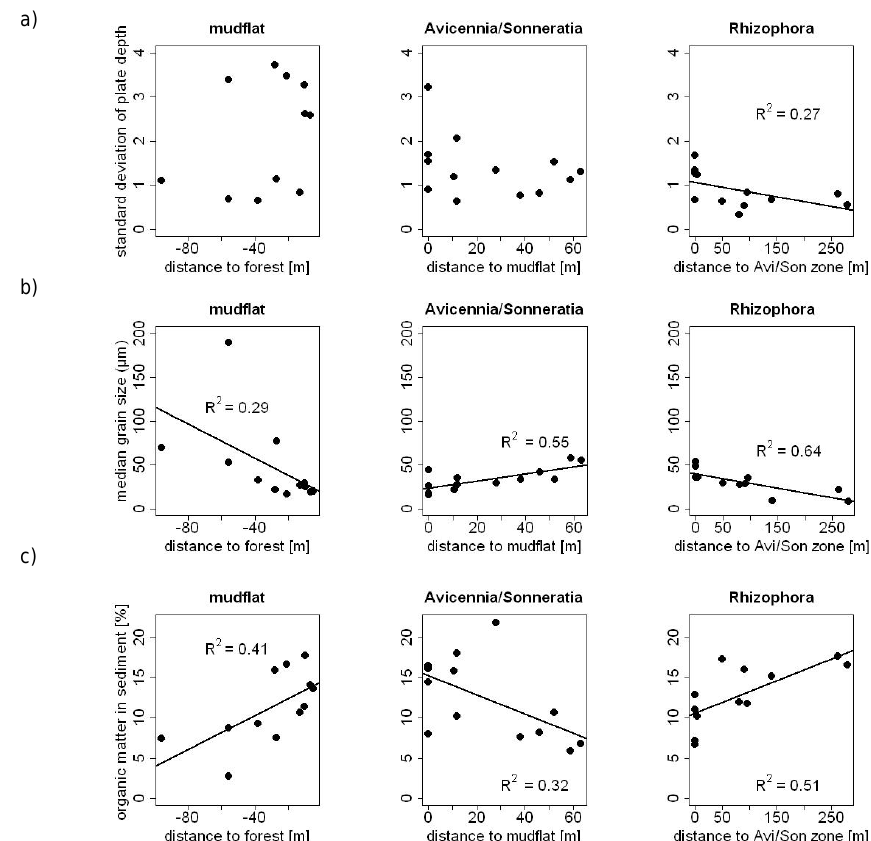
Fig. 4. (a) The standard deviation of the plate depth in time as a measure for magnitude of surface sediment mixing, plotted for all transects per zone and distance from the edge of each zone. While no significant linear relationship is found for the mudflat and the Avicennia/Sonneratia zone, the standard deviation of plate depth decreases with distance in the Rhizophora zone. (b) Median grain size (D50) of the surface sediment samples for all transects per zone. Grain size first decreases towards the forest edge, then increases towards the transition from the Avicennia/Sonneratia to the Rhizophora zone, and thereafter decreases again. The coarsening of the grain sizes in the mangrove fringe could be caused by increased turbulence in the relatively open pioneer zone. (c) Organic matter content of the surface sediment samples for all transects per zone. The organic matter content shows the opposite pattern to that of the grain size; hence finer grains are associated with higher organic matter